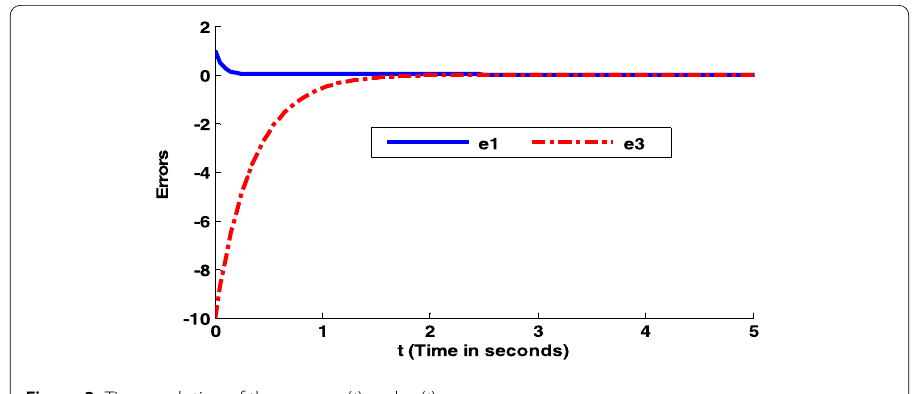
Figure 3 Time evolution of the errors e 1 ( t ) and e 3 ( t )